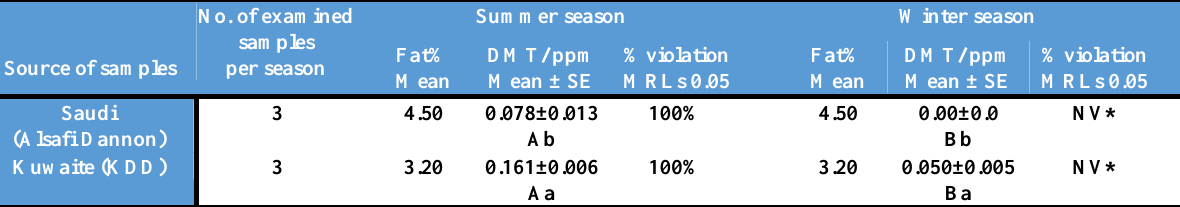
Table, 3: The seasonal variation of the mean levels of Deltamethrin residues (ppm) in imported UHT whole cow's milk samples collected from different supermarkets inside the Baghdad province.